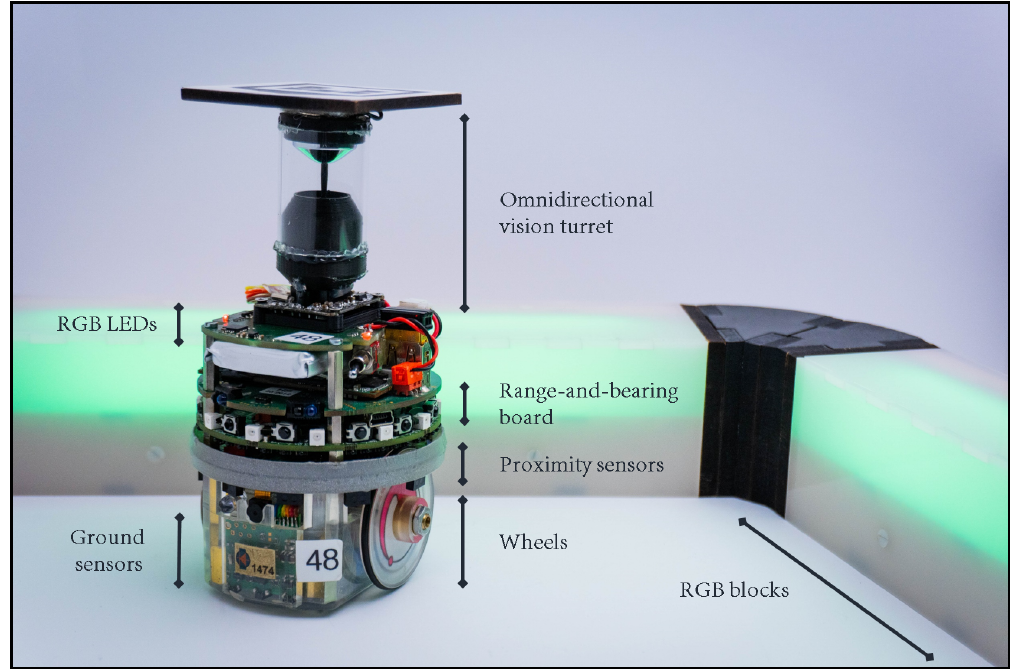
Figure 1. Extended version of the e-puck. The picture indicates the set of sensors and actuators defined by RM3. Alongside, we show the RGB blocks that we use in our experiments with TuttiFrutti . Table 1. Reference model RM 3. Novelties with respect to RM1.1 are highlighted in gray. They concern the capabilities of displaying and perceiving colors. Robots can perceive: red ( R ) ; green ( G ) ; blue ( B ) ; cyan ( C ) ; magenta ( M ) ; and yellow ( Y ) . Robots can display no color ( ∅ ) ; cyan ( C ) ; magenta ( M ) ; and yellow ( Y ) . V c is calculated likewise V n —for each perceived color, the positions of color signals are aggregated into a unique attraction